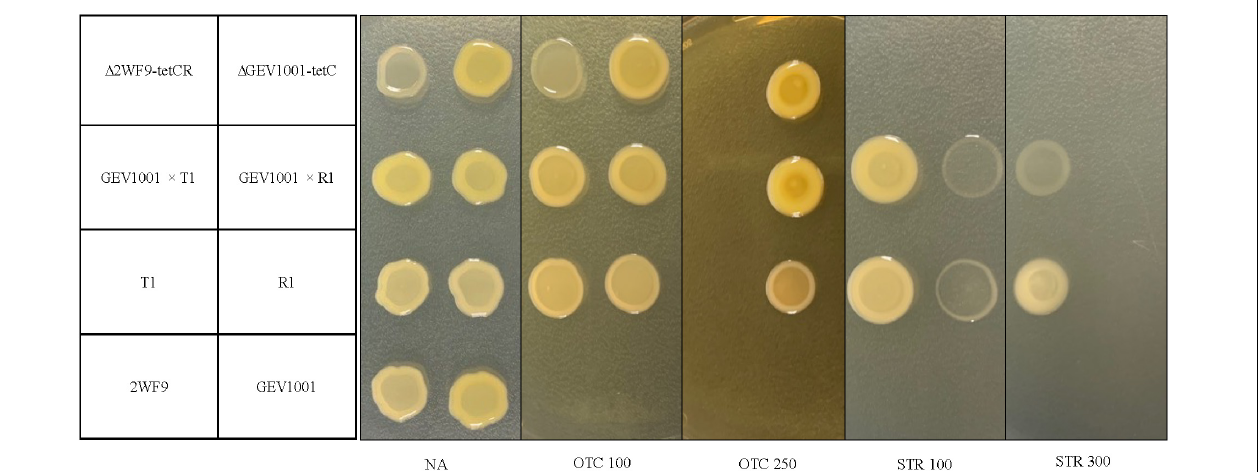
FIGURE 1 | Growth of bacterial strains at 4 days after incubation on nutrient agar (NA), NA amended with 100 or 250 µ g/mL of oxytetracycline (OTC 100 and OTC 250) and NA amended with 100 or 300 µ g/mL of streptomycin (STR 100 and STR 300). Bacterial strains include: 2WF9 [an OTC- and STR-sensitive, rifampicin-resistant strain, Xanthomonas arboricola pv. pruni ( Xap )], GEV1001 (an OTC- and STR-sensitive, rifampicin-resistant strain, Xanthomonas perforans ), T1 and R1 (OTC- and STR-resistant wild-type strains, Xap ), transconjugants with GEV1001 as recipient and T1 or R1 as donors (GEV1001 × pT1 and GEV1001 × pR1), the mutant of 2WF9 with insertion of tetCR genes cloned from T1 ( (cid:49) 2WF9- tetCR ), and the mutant of GEV1001 with the insertion of tetC gene cloned from T1 ( (cid:49) GEV1001- tetC ). The strains were identified to the species levels using the Xap - and X. perforans -specific qPCR assays (Palacio-Bielsa et al., 2011; Strayer et al.,